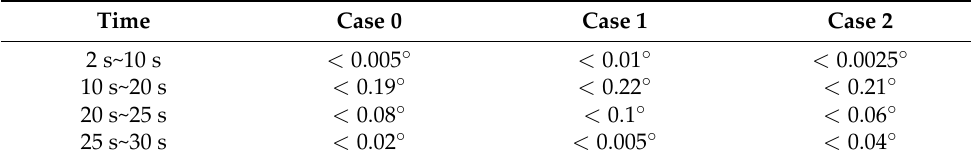
Figure 9. Tracking errors under three cases. Table 2. Tracking errors of attack angle at different time periods.